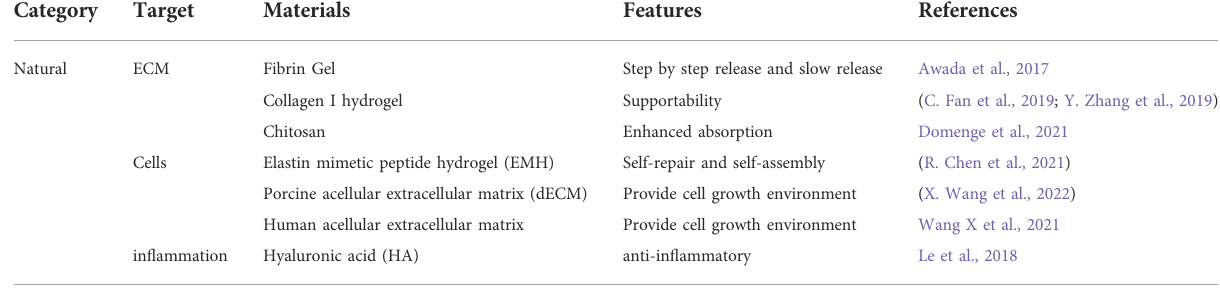
TABLE 1 Naturally sourced gel materials.